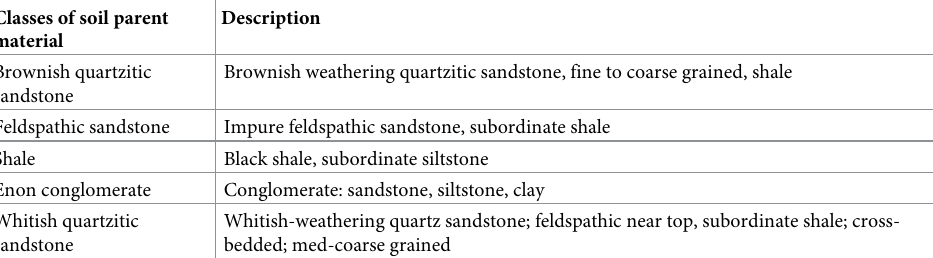
Table 4. Selected classes of soil parent material for BACI contrast comparison with the largest area coverage in the intervened sites.